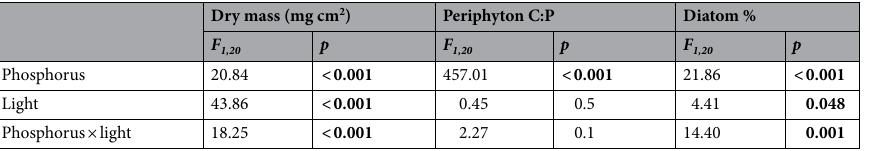
Table 1. Results of two-way ANOVAs on the effects of phosphorus and light on periphyton dry mass, molar C:P ratio and diatom percentage contribution to total chlorophyll a at the beginning of the grazing phase. Significant effects ( p < 0.05) are highlighted in